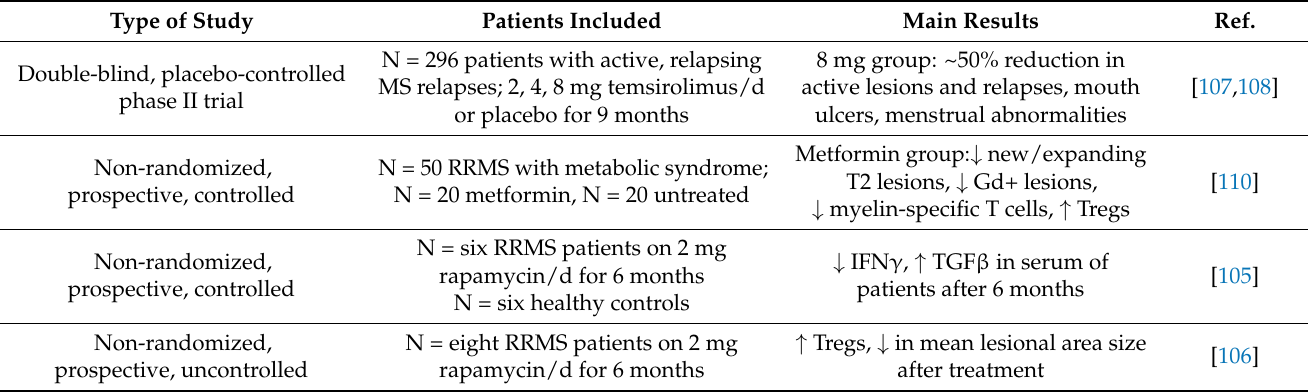
Table 3. Studies of mTOR inhibitors in multiple sclerosis patients. Type of Study Patients Included Main Results